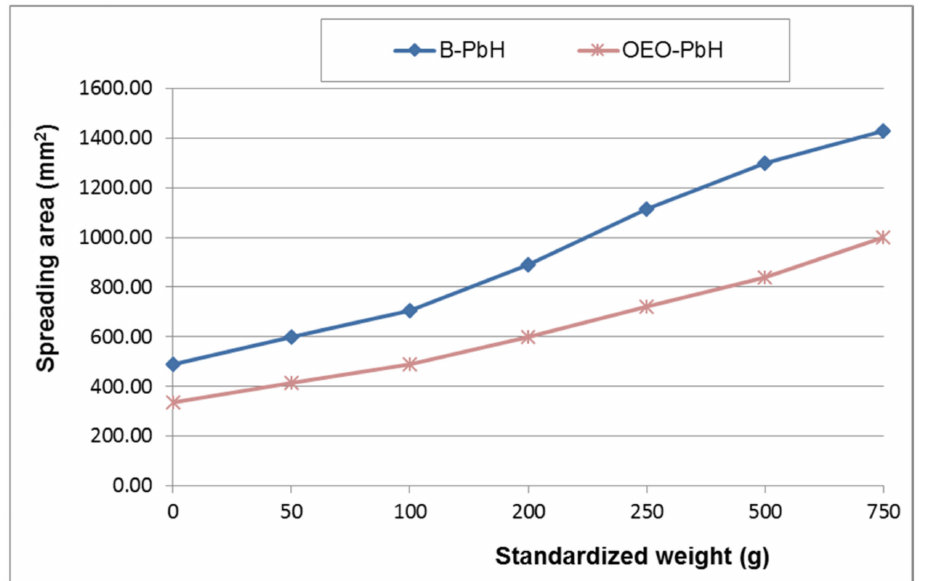
Figure 3. Extensiometric profiles of experimental poloxamer binary hydrogels (B-PbH and OEO-PbH).